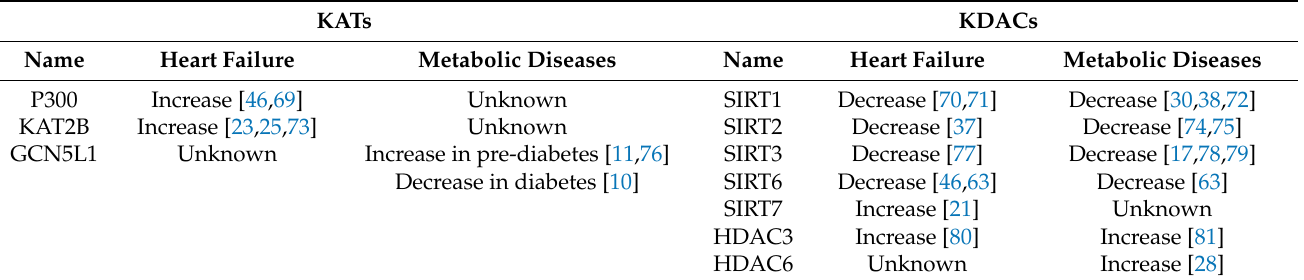
Table 2. Modulation of KATs and KDACs expression in heart failure and metabolic